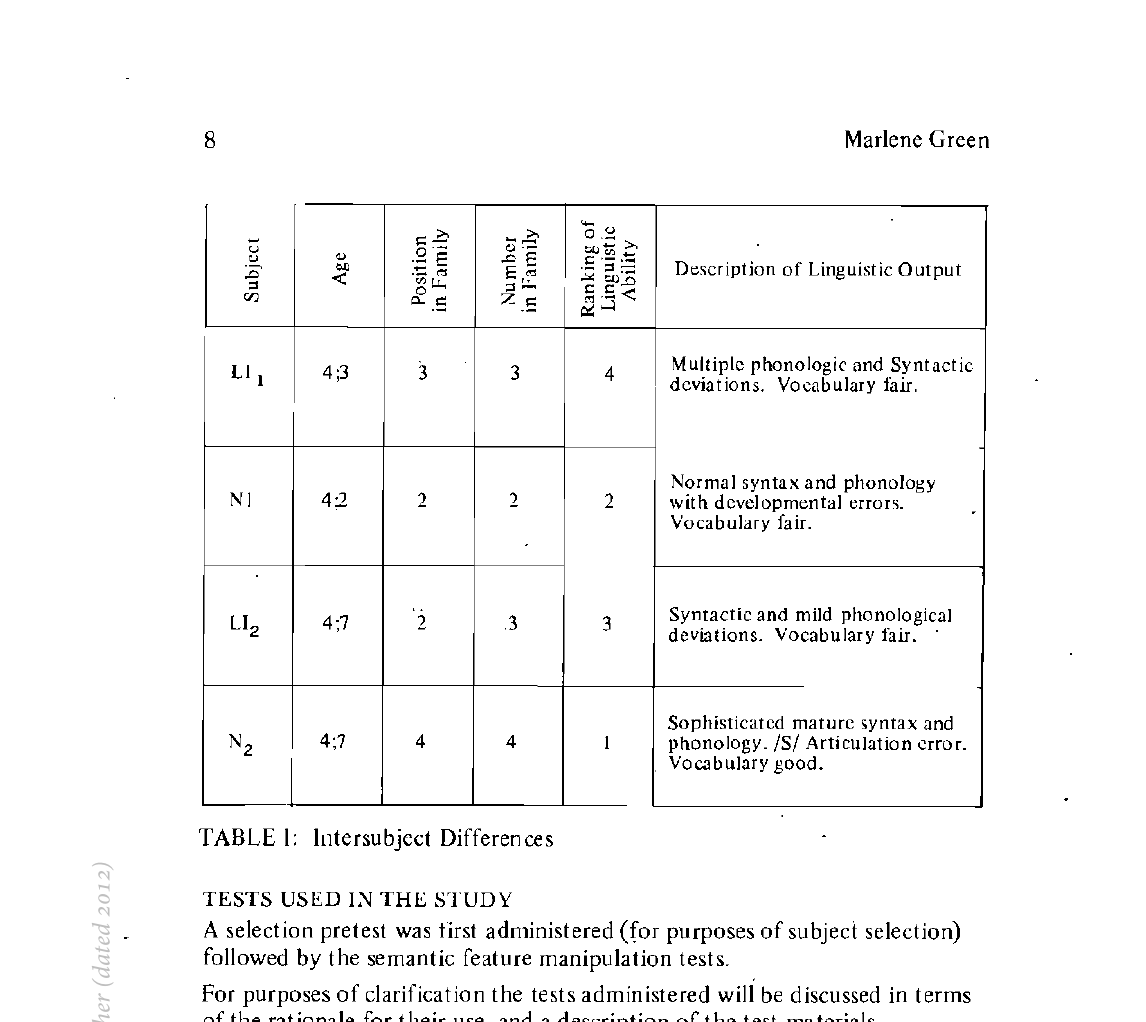
TABLE 1: lntersubject Differences TESTS USED IN THE